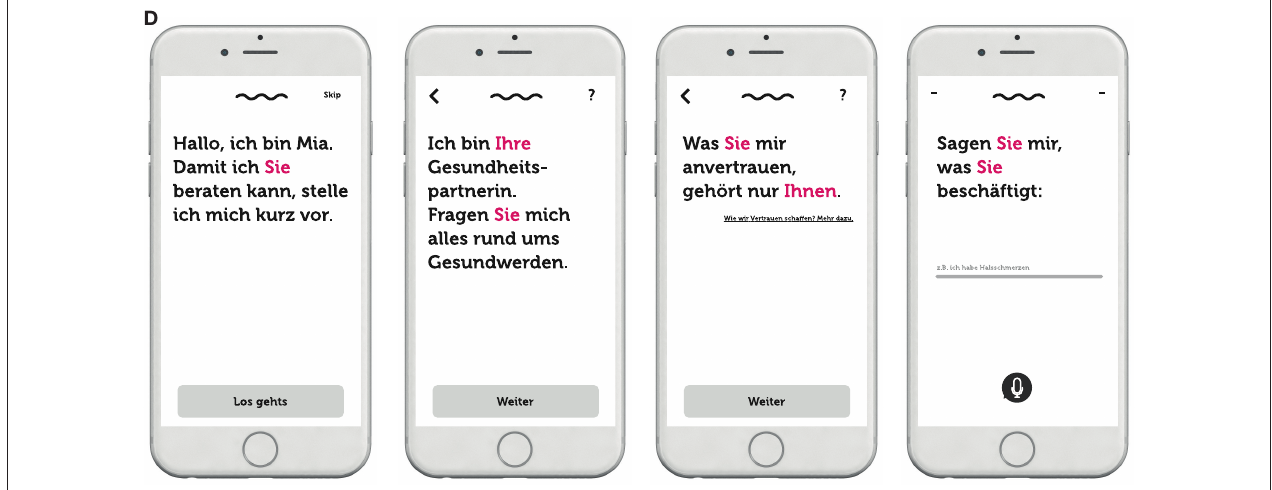
FIGURE 2 | (A) Experimental stimuli—French T form. (B) Experimental stimuli—German T form. (C) Experimental stimuli—French V form. (D) Experimental stimuli—German V form. Note: Manipulations highlighted in